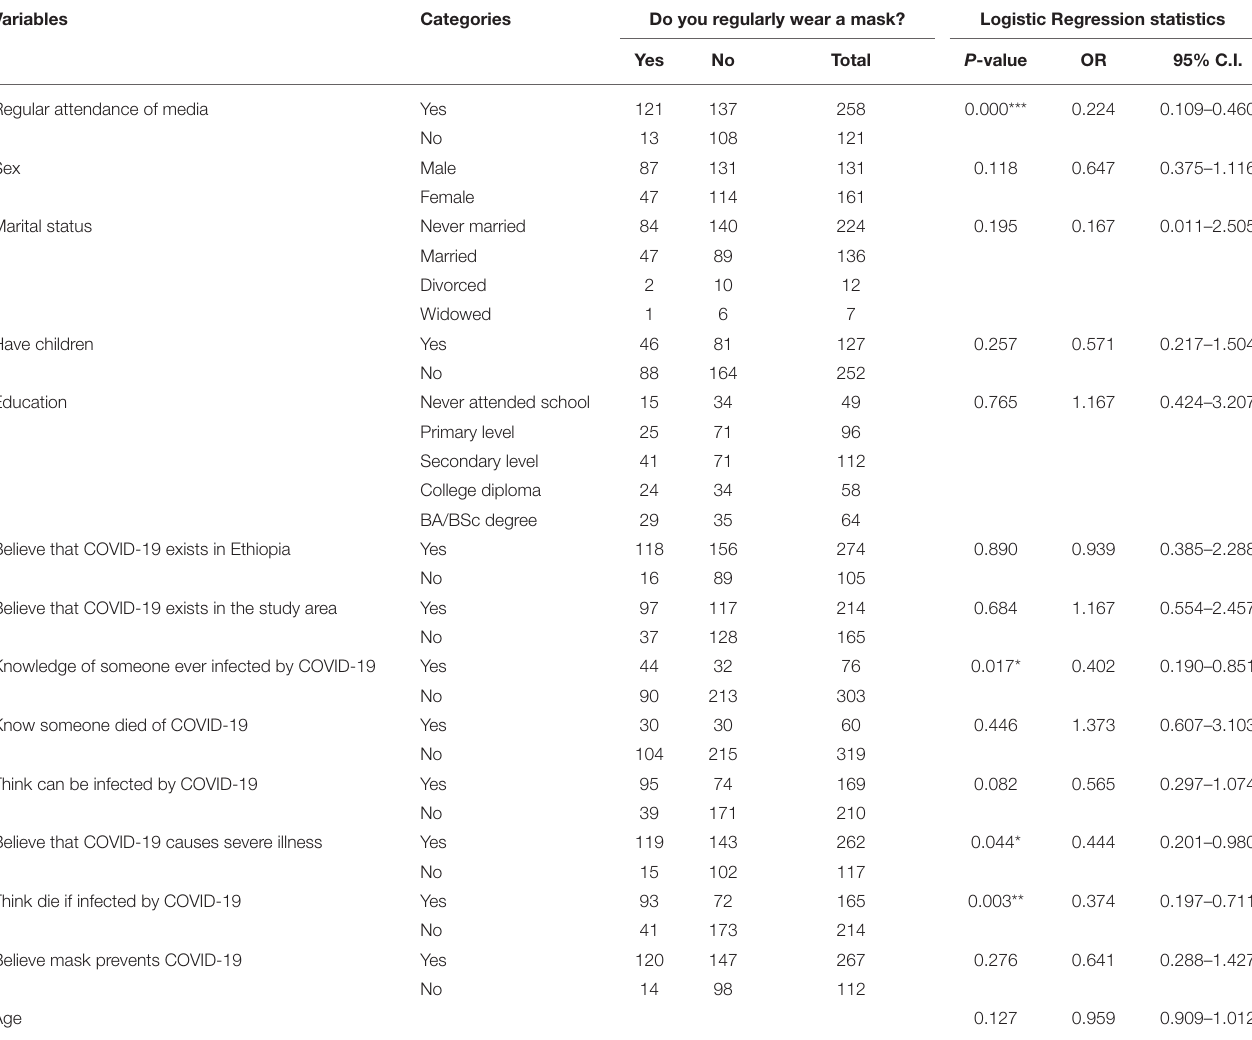
TABLE 5 | Binary logistic regression showing association between socio-demographic characteristics and practices of regular mask wear. Variables Categories Do you regularly wear a mask? Logistic Regression statistics Yes No Total P -value OR 95%